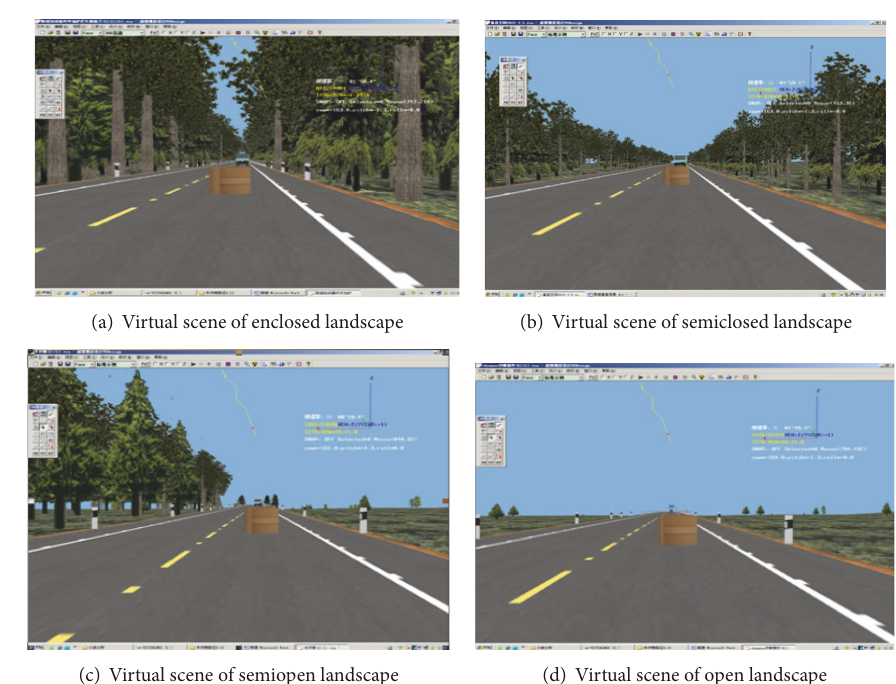
Figure 4: Four types of virtual landscapes designed using